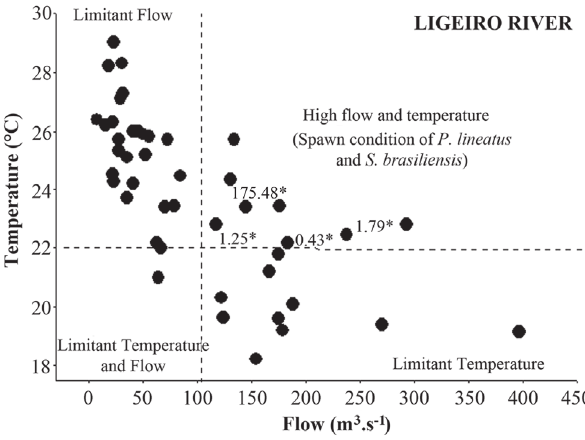
Fig 5. Mean monthly values for water flow and water temperature of the Ligeiro River during reproductive periods from October 2001 to February 2010. *Density of Prochilodus lineatus and Salminus brasiliensis captured eggs (1.79 eggs/ 10m 3 in Dec/2003; Nov/08= 0.43 eggs/10m 3 in Nov/2008; 1.25 eggs/10m 3 in Dec/2009; 175.48 eggs/10m 3 in Jan/2010). The value in bold indicates only S. brasiliensis